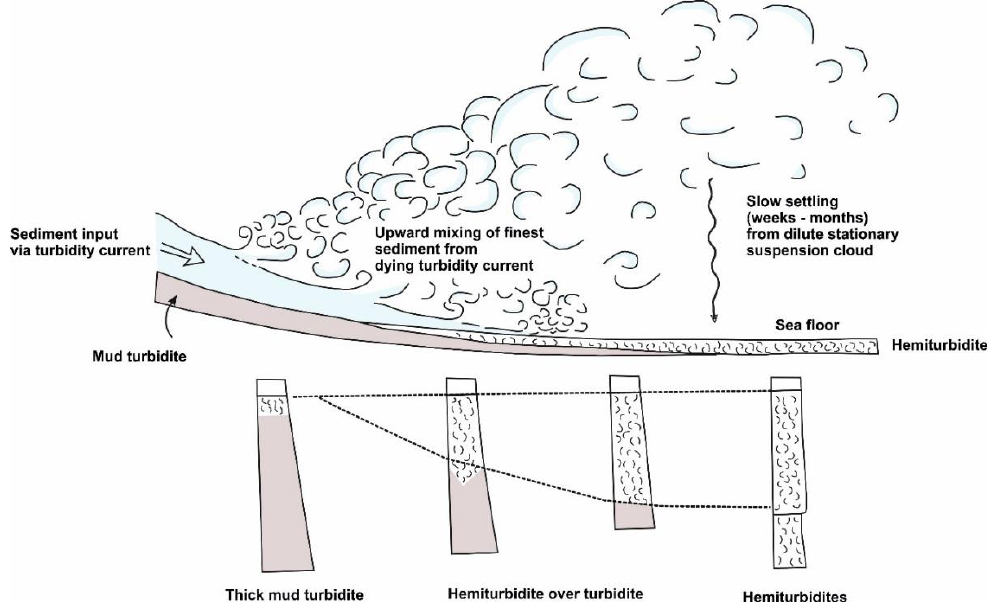
Figure 3. Schematic view (2D) of the flow-lofting process at the most distal end of a turbidity current. Deposition of distal mud turbidites and hemiturbidites as shown. Modified from